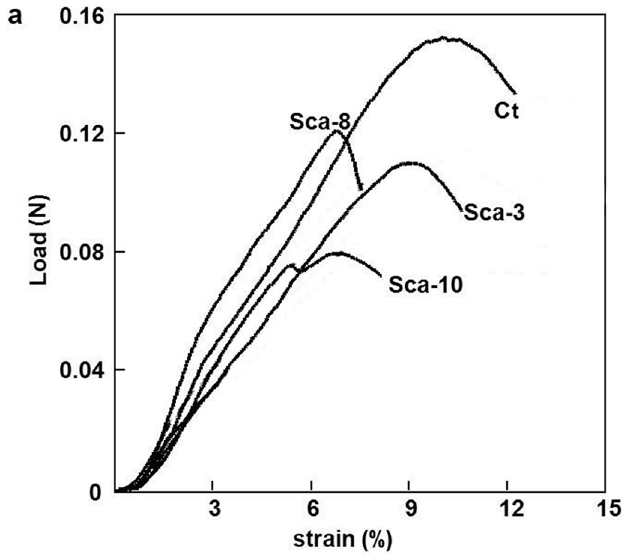
Fig 5. The detection of the mechanical properties of composite silk fibers. (A) The measurement of the load (N) of the transgenic silk. (B) The measurement of the relative tensile modulus.